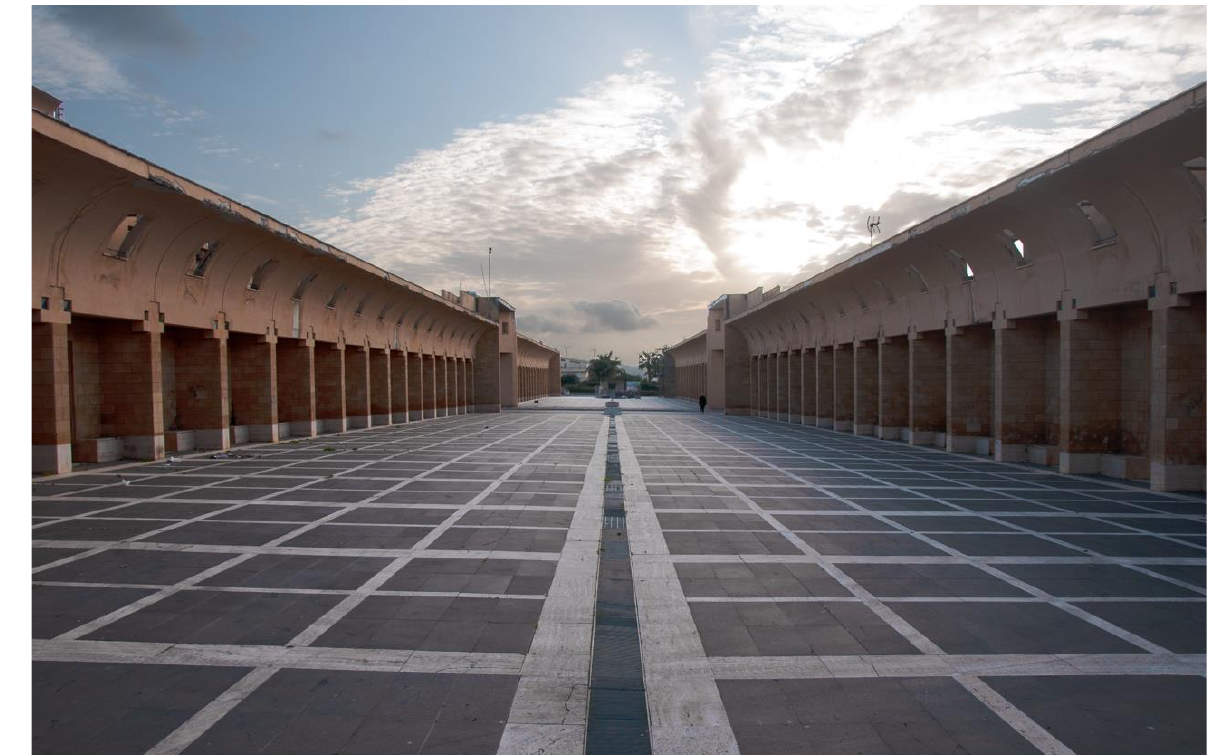
Figure 12. Sistema delle Piazze, Gibellina, project by Franco Purini and Laura Thermes (1990). Photo by the authors, Gibellina 2020.